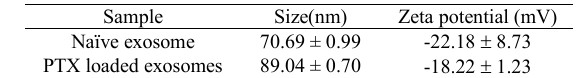
Table 2: Mean hydrodynamic diameter and Zeta potential of naïve and PTX loaded exosomes